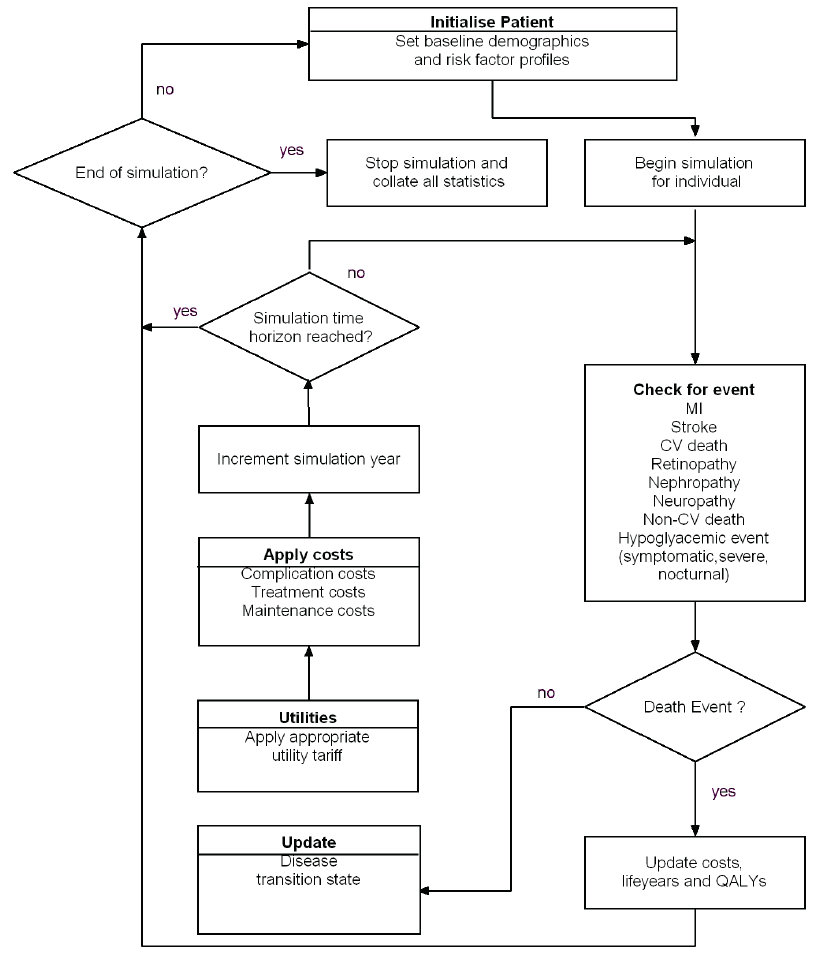
Figure 1. Flow Diagram of the T2DM Discrete Event Simulation